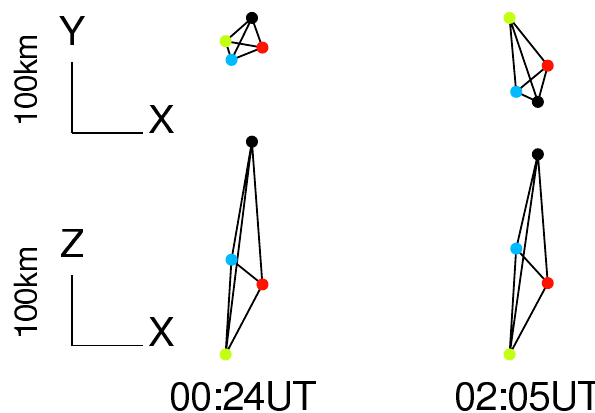
Fig. 4. Spacecraft constellations mapped to the X-Y and the X- Z planes in SM coordinates. The left and right part correspond to constellations during inbound and outbound plume crossings on 12 June 2002 at 00:24UT and 02:05UT, respectively. C1–4 are shown by black, red, green and blue,